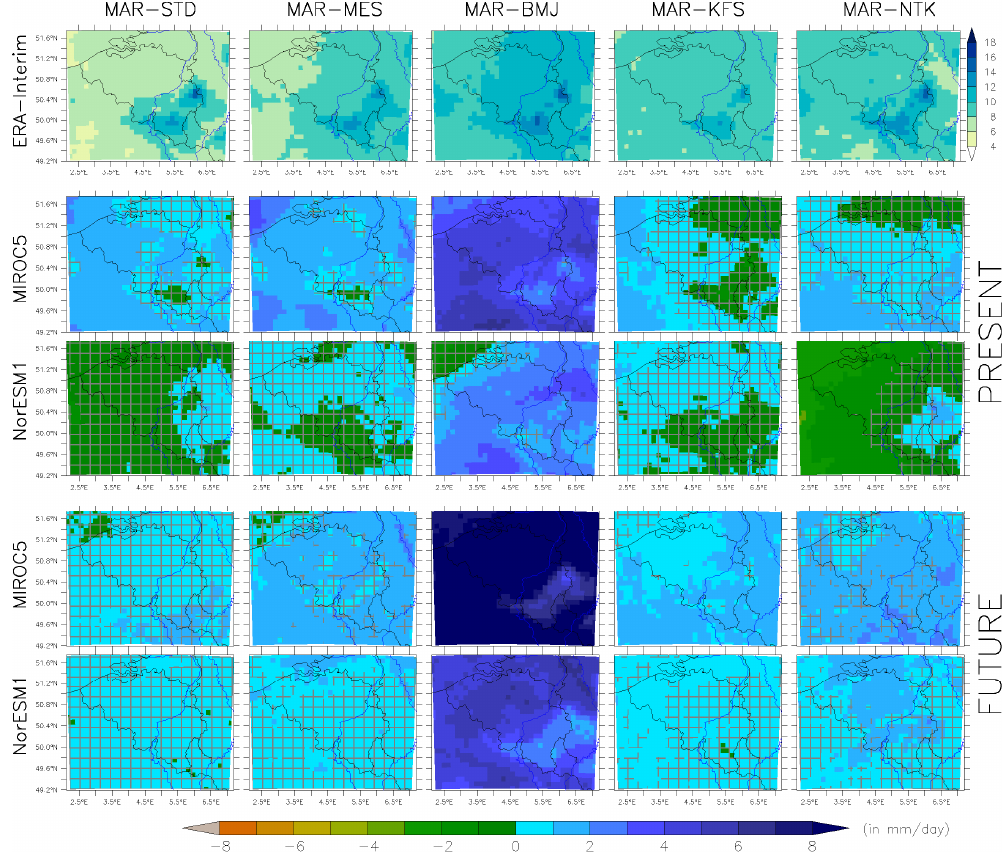
Figure 3. Same as Figure 2, but for the 95th percentile of daily precipitation in mm/day.